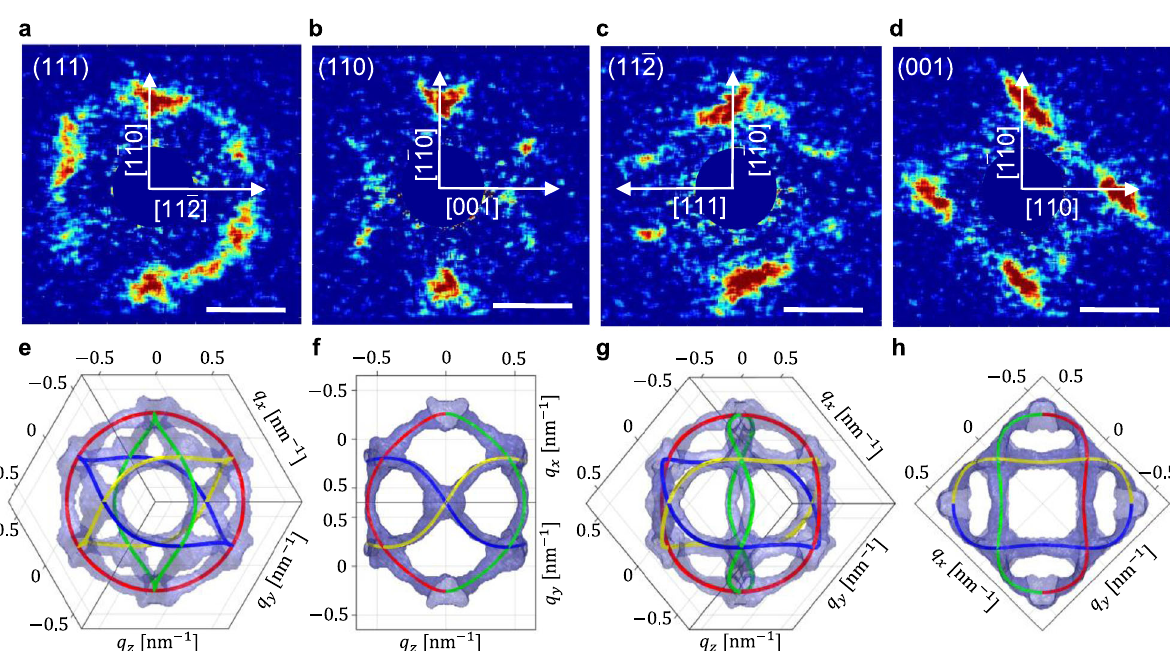
Fig. 2 SANS images of GaMo 4 S 8 and reciprocal space distribution of the cycloidal wavevectors. In panels a – d SANS images are collected at 2 K. The scale bars represent 0.5 nm − 1 . In e – h , the q-vector distribution is shown from the direction of the neutron beam in ( a – d ), respectively. The perturbative solution of the model potential in Eq. (1) fi tted to the experimental data is visualized by solid curves plotted over the experimental data. The four different colours represent scattering from the four rhombohedral domain